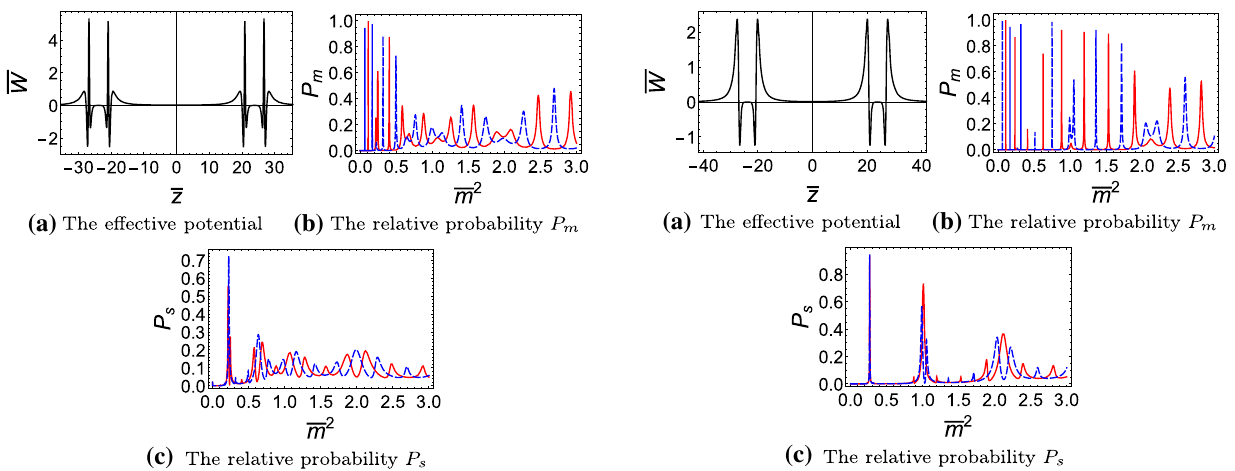
Fig. 25 The effective potential, the relative probabilities of the even parity KK mode ψ e (dashed blue lines) and the odd parity KK mode ψ o (solid red lines) quasi-localized between the sub-wells P m and in the sub-wells P s with ¯ b = 13, ¯ d = 2 . 3, and ¯ α = − 0 . 00126 for case